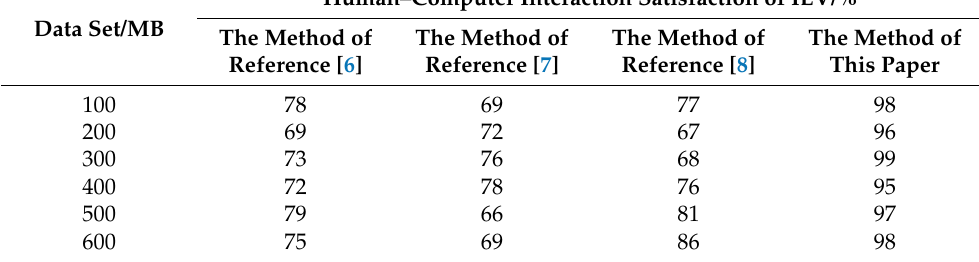
Table 3. Human computer interaction satisfaction of